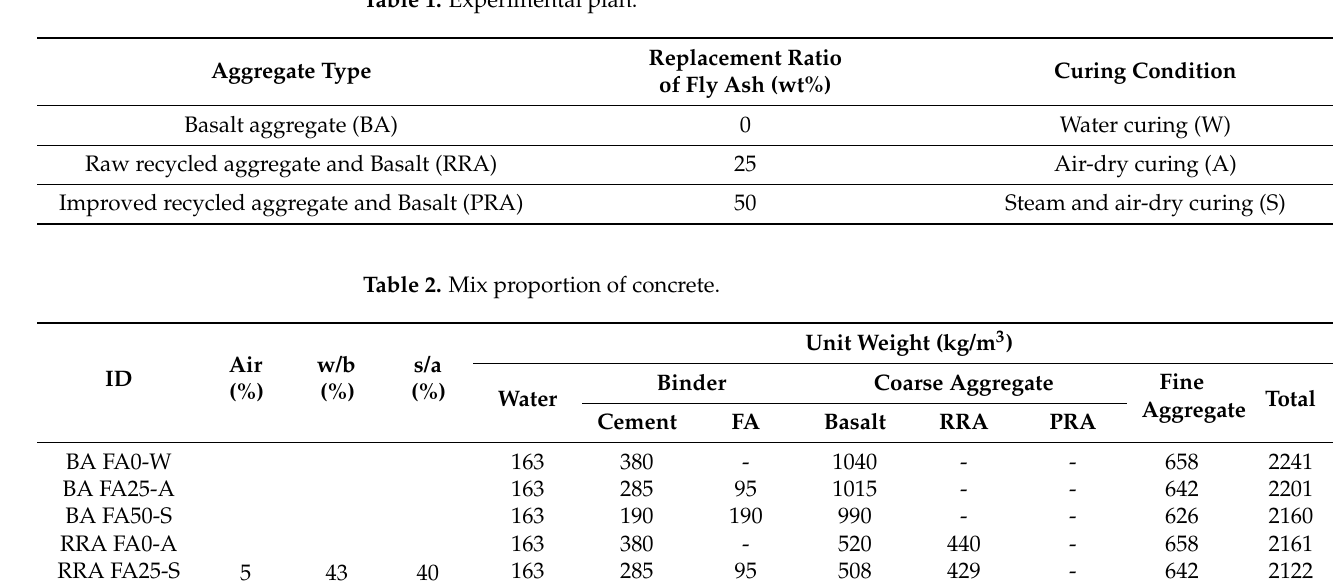
Table 1. Experimental plan.